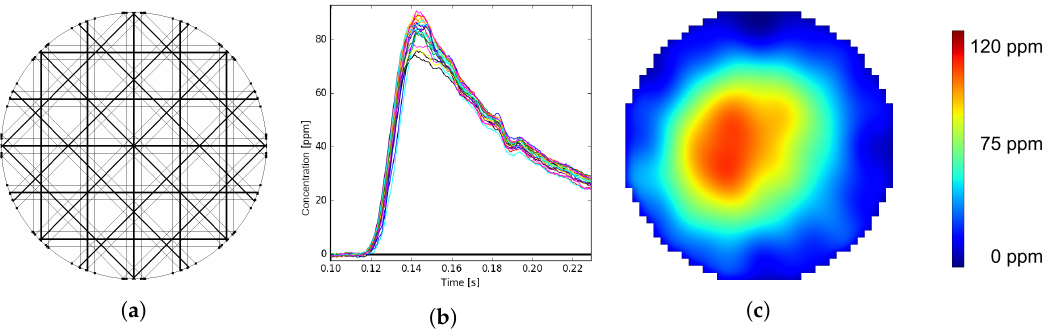
Figure 6. Measurement procedure; ( a ) regular beam arrangement of 20 beams through the cross-section; ( b ) time signal of one injection pulse measuring 20 line concentrations; ( c ) gas distribution after reconstructing the line concentrations at the peak of a injection pulse.